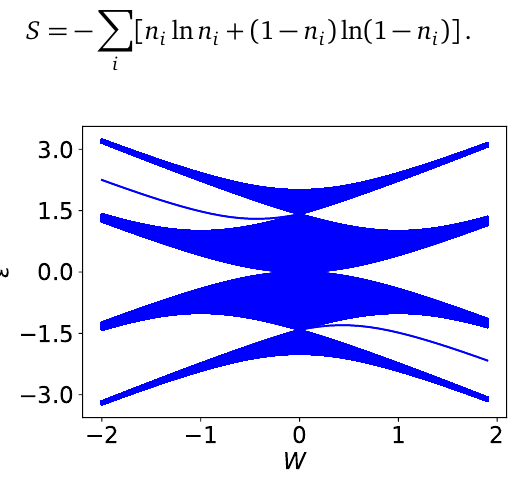
Figure 2: Energy spectrum with OBC with varying values of W . The calculations are performed on a ladder with N = 2000 sites in each leg, with t